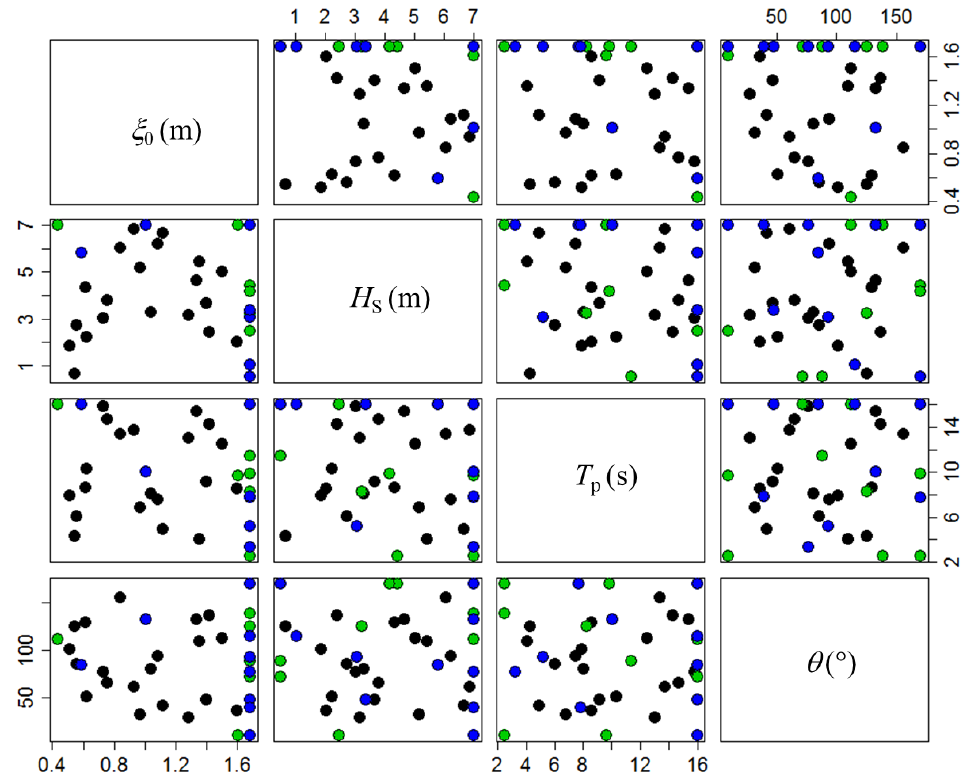
Fig. 8. Matrix of scatter plots showing the training data in the four- dimensional domain of offshore conditions: initial (black dots), 10 first adaptively selected training data (green dots), and 10 additional ones (blue dots).